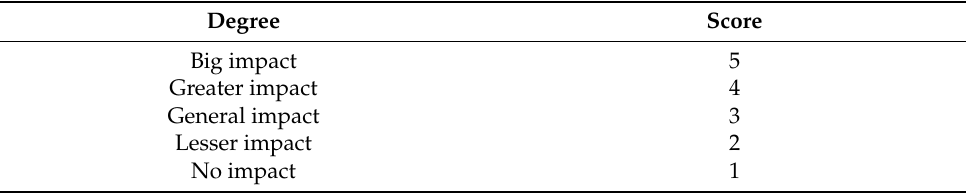
Table 1. The scoring standard